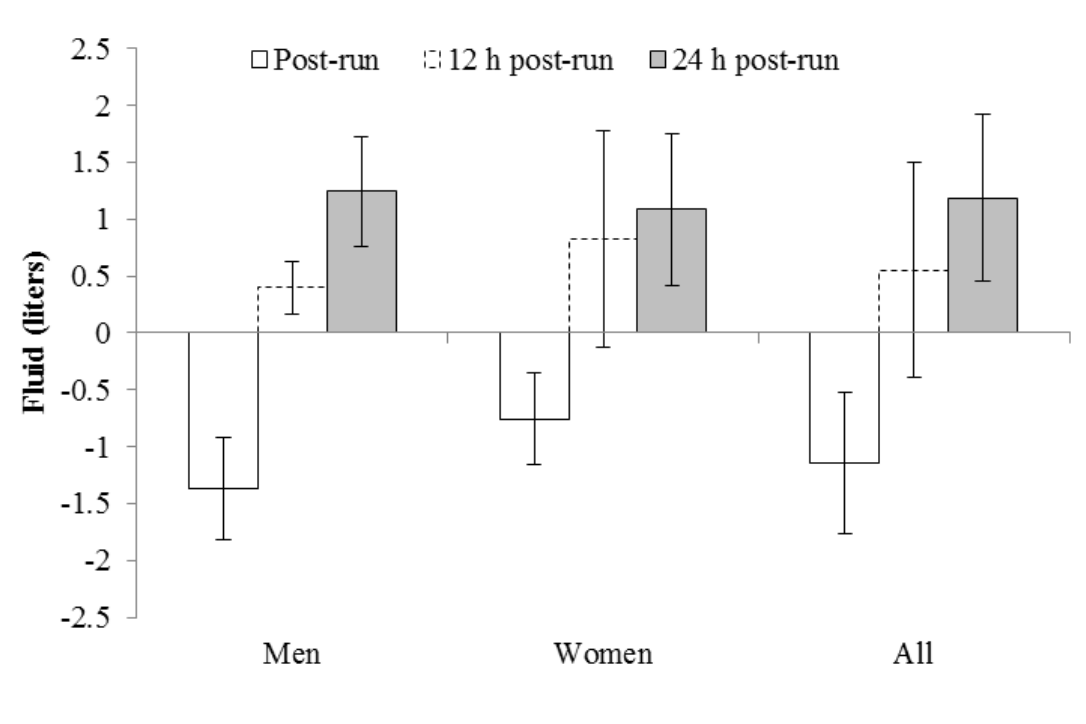
Figure 3. Group fluid turnover based on sweat losses, fluid intake, and urine output ( n